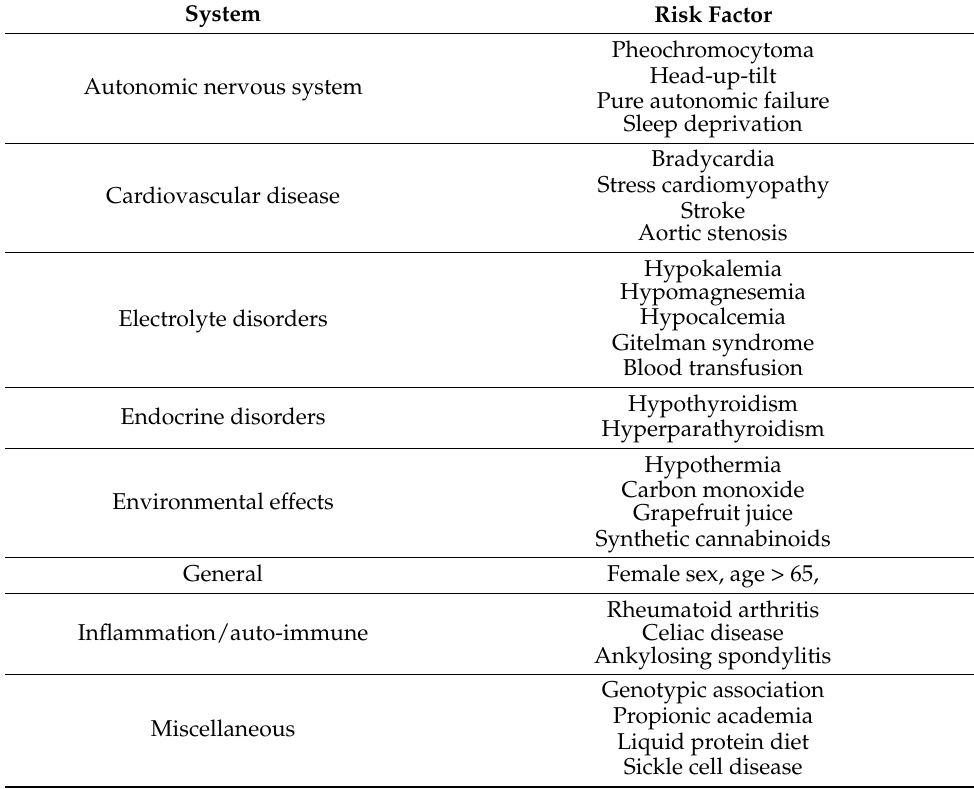
Table 3. Clinical factors associated with prolonged